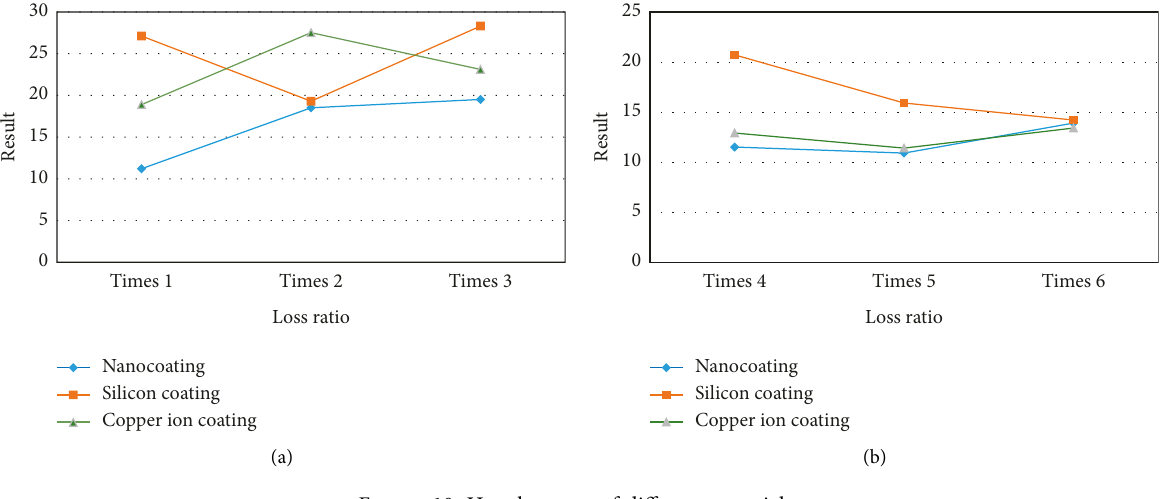
Figure 10: Heat loss rate of different